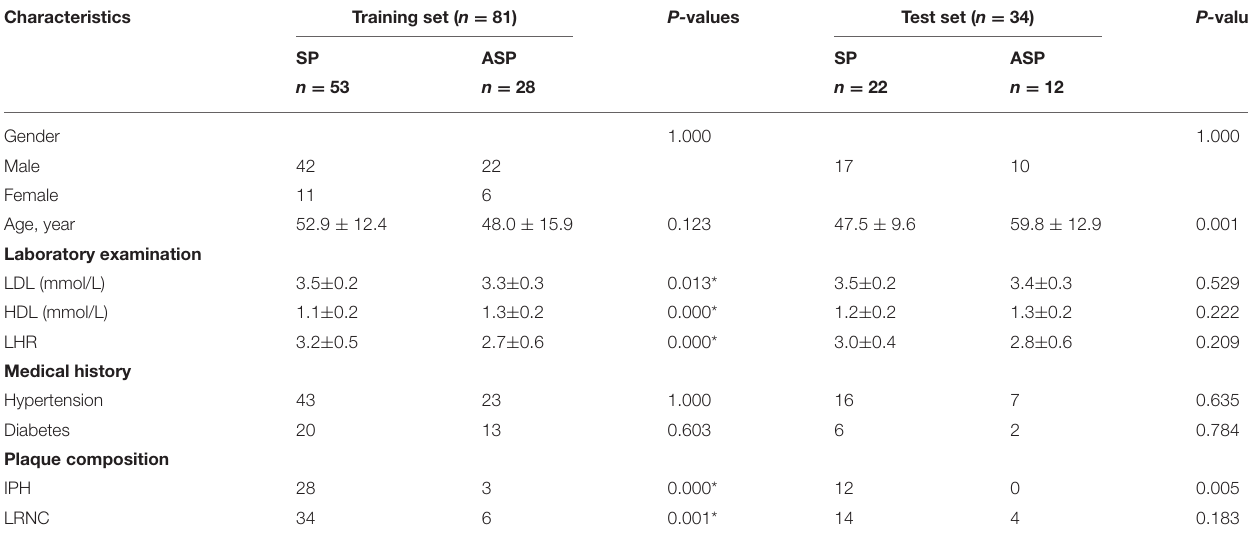
TABLE 2 | Clinicopathological characteristics of APs and ASPs in a training group and a test group. Characteristics